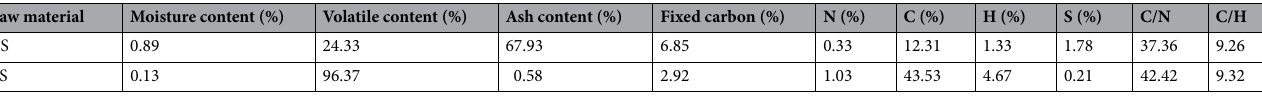
Table 1. Basic features of OS and CS.